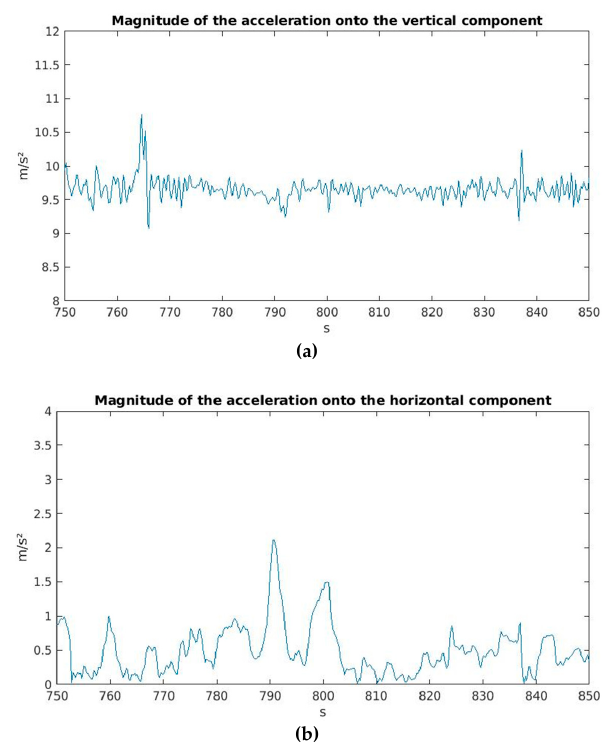
Figure 3. Decomposition of 3 ‐ dimensional accelerometer signal: (a) vertical projection. (b) horizontal projection. ( b ) horizontal